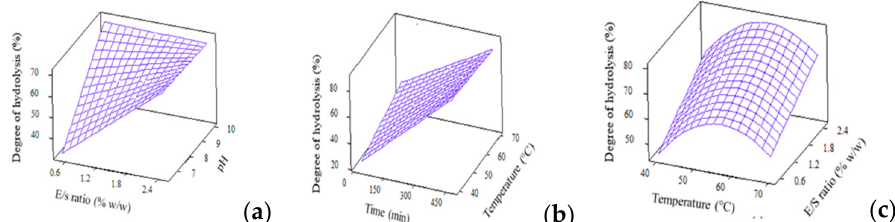
Figure 2. 3D surface plots for degree of hydrolysis (%) as affected by ( a ) E/S ratio and pH; ( b ) Time and temperature and ( c ) Temperature and E/S ratio.